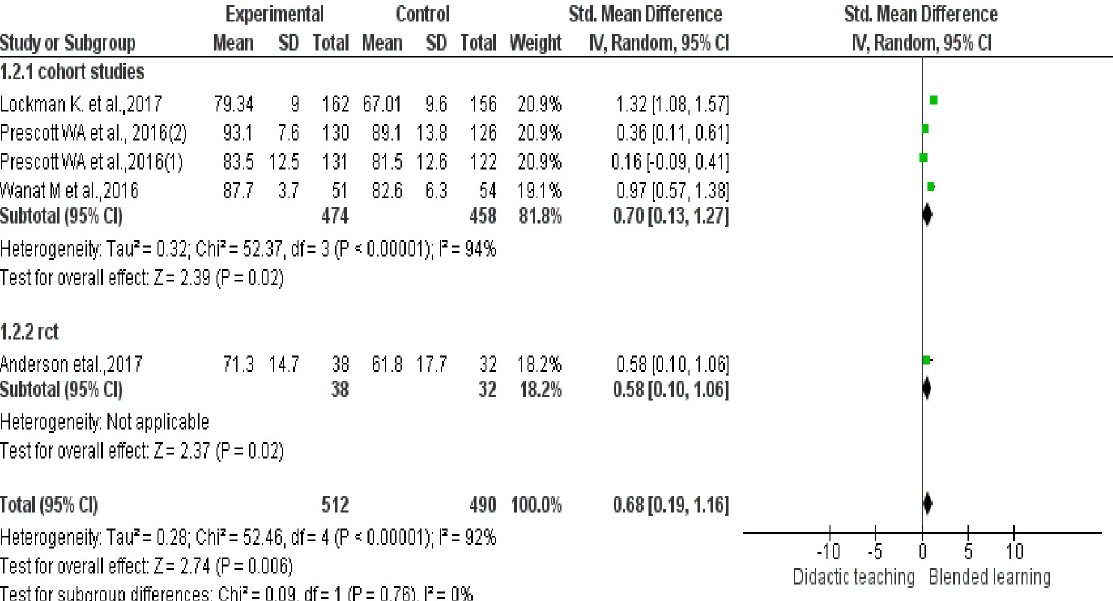
Fig 3. Efficacy of BL vs. traditional teaching in improving skill. If more than one topic was delivered by BL in same study (Prescott) with separate scores for each, we considered them as separate studies (Prescott 1&2).